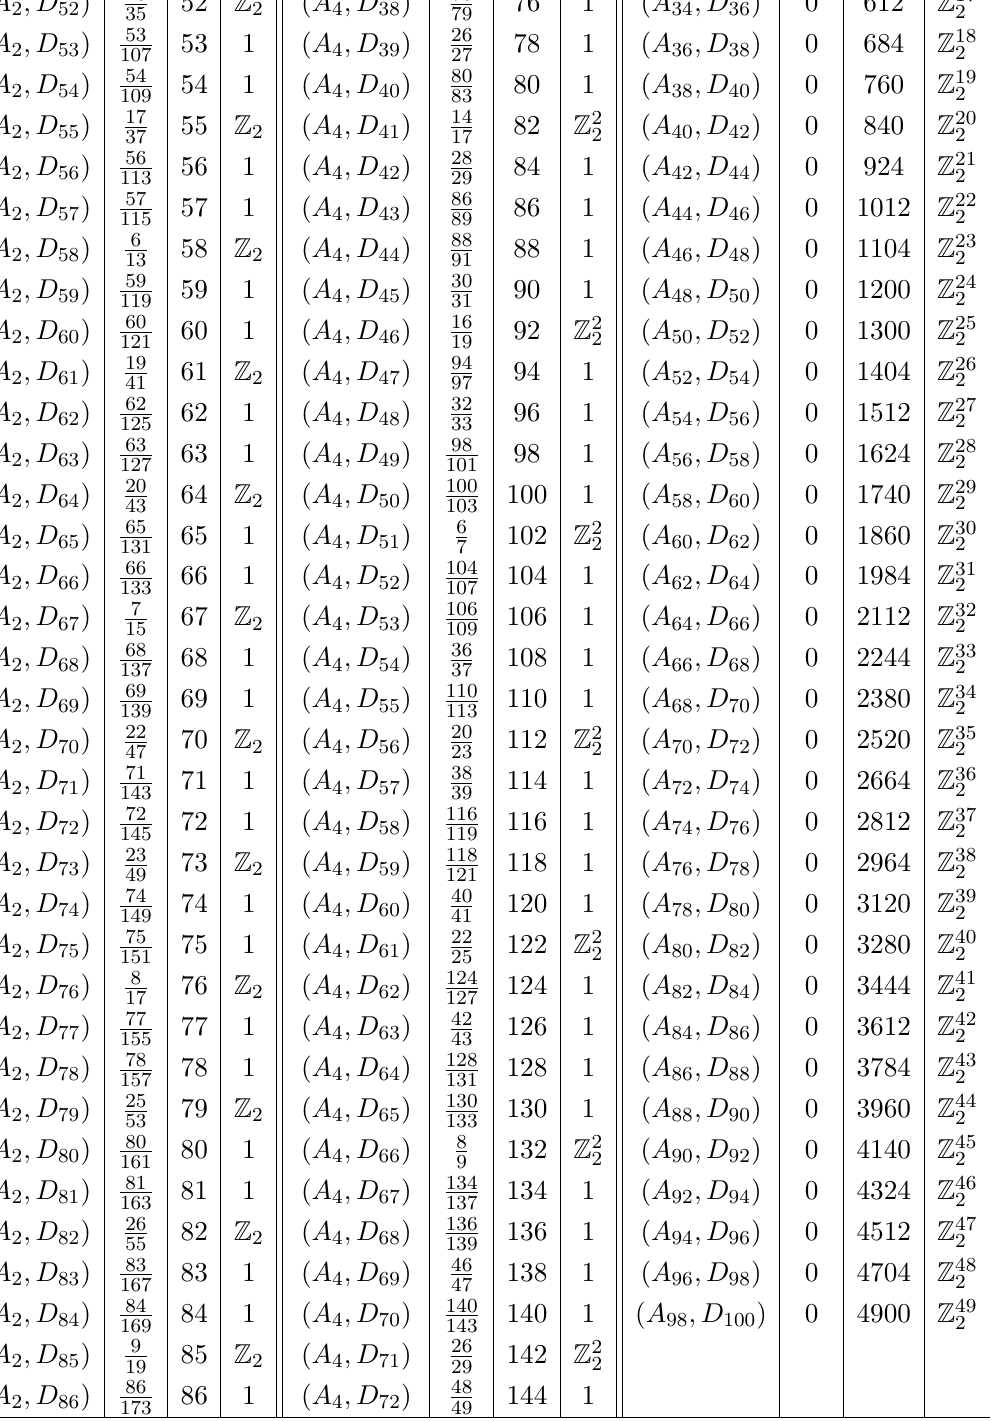
) with 1 ≤ n, m ≤ 100 . We called h = 24( c − a ) , r the rank of the SCFT Table 2 : ( A , D n m and s the 1 -form symmetry group. We list only those theories with 0 ≤ h < 1